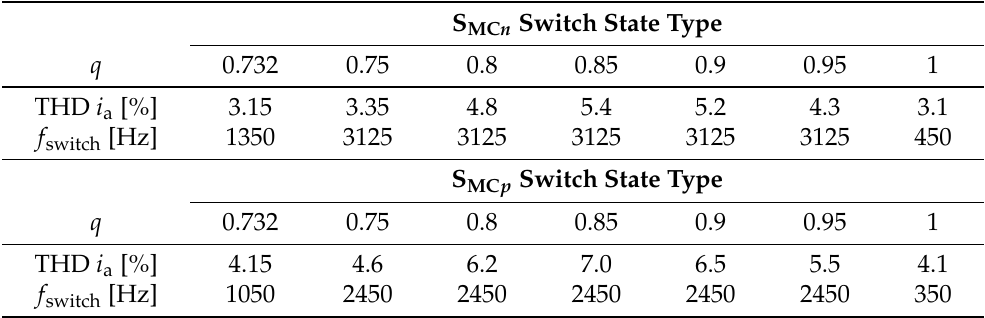
Table 7. Comparison of load current THD and average switching frequency for PWR modulation using the S MC n switch state sequences and k f =